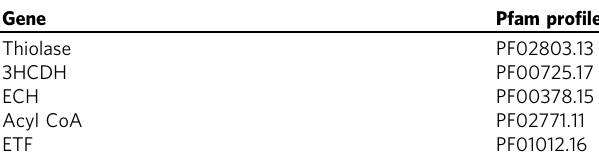
Table 2 Pfam pro fi les used to identify the pathway for pyruvate